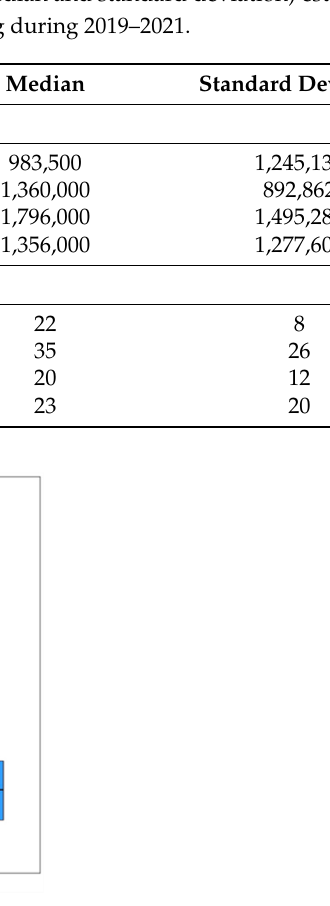
Figure 2. Boxplots based on pollen production per catkin ( P ca ) (eight replications per tree) estimated for 28 trees in the seed plantation in Wildberg for 2019, 2020 and 2021. The interquartile range is represented by the height of the boxes, maximum and minimum values by the upper and lower whiskers, the median by bold horizontal lines in the boxes, points indicate outliers, lines above boxplots indicate pair of years, which were significantly different (Kruskal–Wallis test and Dunn’s multiple comparison’s tests).